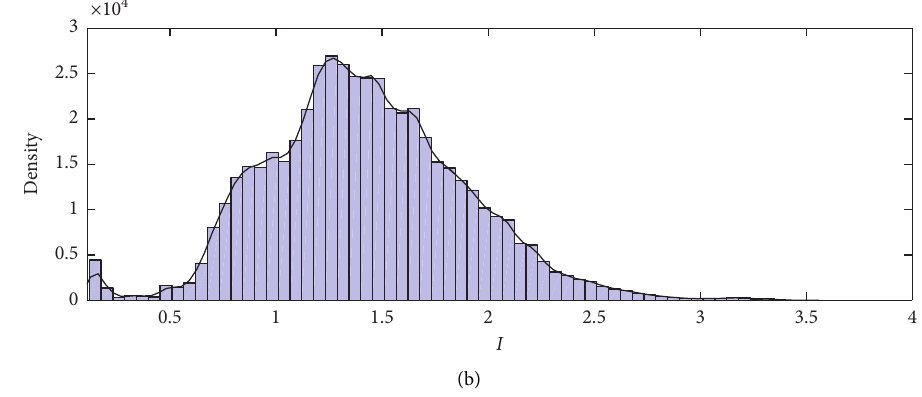
Figure 4: The solution I(t) of stochastic model (3) and its histogram.